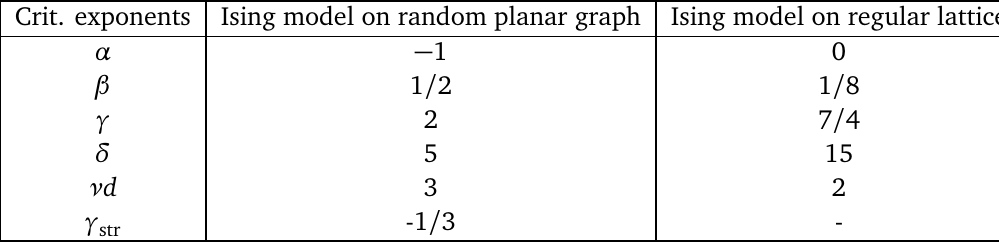
Table 5: Summary of critical exponents obtained for two-dimensional Ising model. Crit.